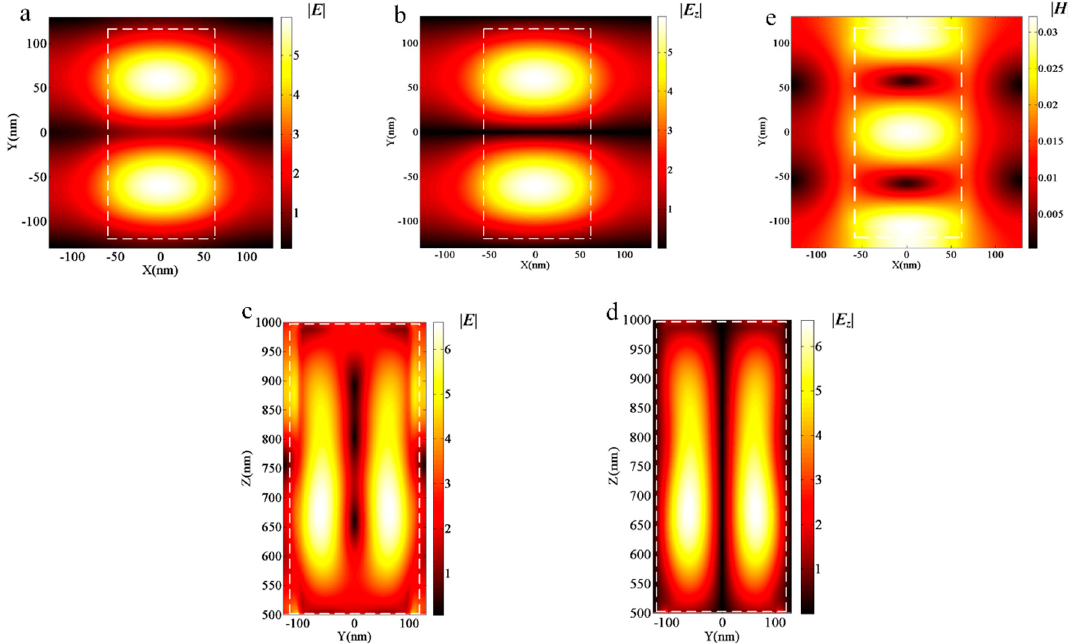
Figure 4. The field distribution of metasurfaces with L x = 138 nm and L y = 203 nm for the y -polarized incidence. ( a ) The electric field distribution in the central x – y plane of GaN scatterers. ( b ) The z component distribution of the electric field in the central x – y plane of GaN scatterers. ( c ) The electric field distribution in the y – z plane, x = 0. ( d ) The z-component distribution of the electric field in the y – z plane, x = 0. ( e ) The magnetic field distribution in the central x – y plane of GaN